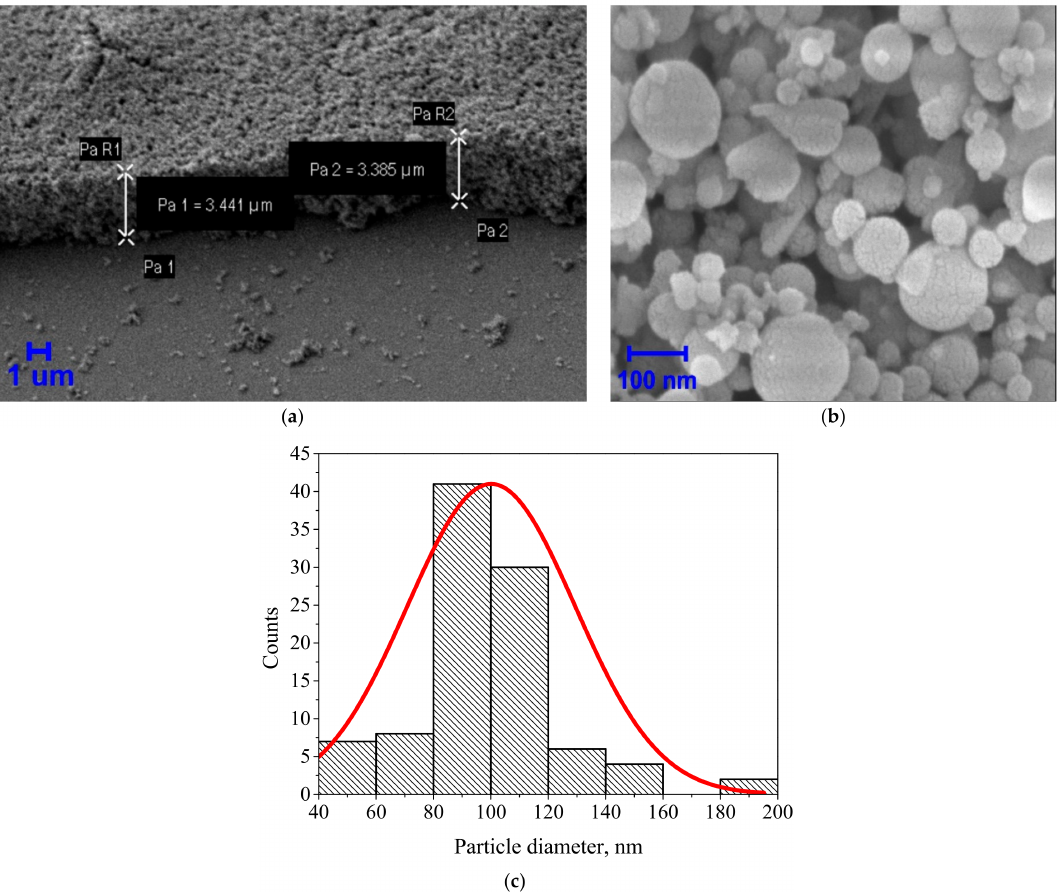
Figure 1. SEM images of Si nanogranular film ( a ) and a closer view of Si NPs ( b ) within a film with a typical NP size of 100 ± 50 nm ( c